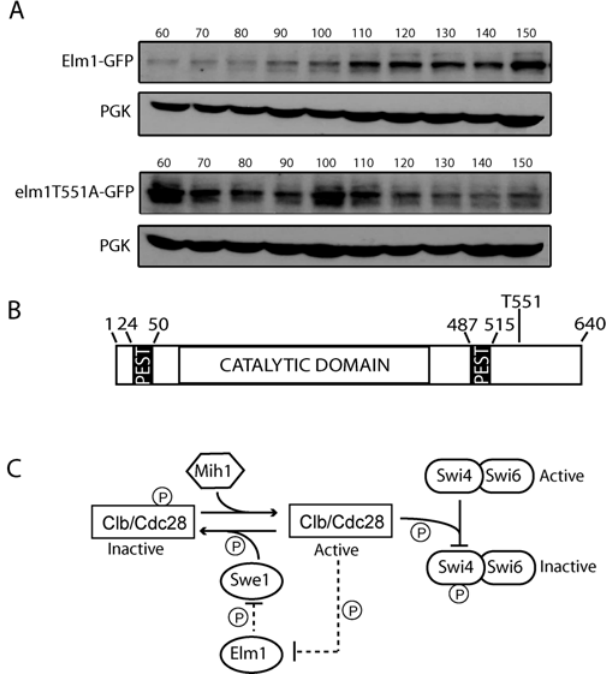
Figure 6. A proposed mechanism of Elm1 involvement in regulation of SBF activity in yeast. (A) Western blot analysis of Elm1-GFP and elm1T551A-GFP expressed from the endogenous promoter in synchro- nized cells using Anti-GFP antibody. As a loading control, blots were probed with anti-3-phosphoglycerate kinase (PGK) antibody. (B) Schematic diagram of the Elm1 protein indicating the location of the two PEST motifs in the N- and C-termini, the catalytic domain, and threonine-551 of the single full consensus site of Cdc28 phosphoryla- tion. (C) A proposed model whereby Elm1 functions upstream of Swe1 to relieve its inhibition of Clb/Cdc28 activity. Elm1 may also be phosphorylated by Cdc28 in a negative feedback loop to induce its degradation upon completion of mitosis. Hypothetical interactions are indicated by dashed lines, solid lines represent interactions previously reported in the